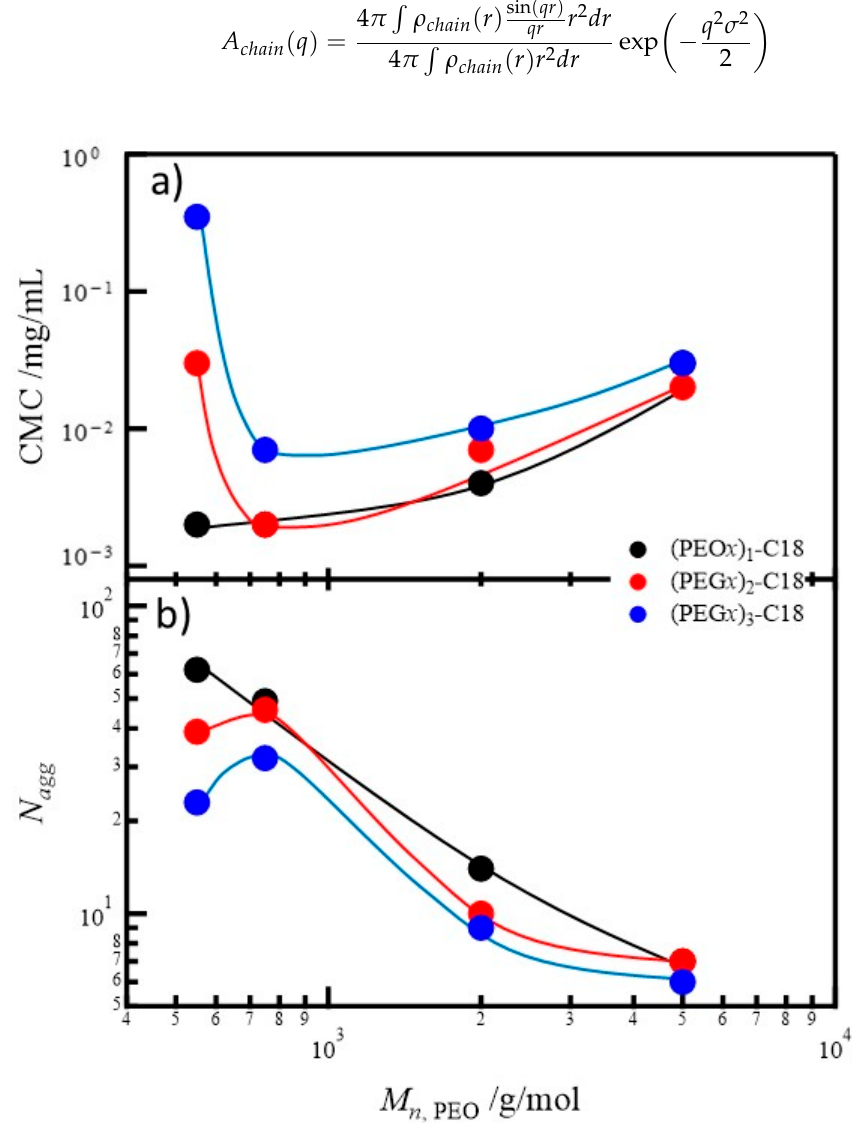
Figure 2. M n ,PEO dependence of CMC (a) and N agg (b) of aqueous (PEO x ) y -C18 solutions.